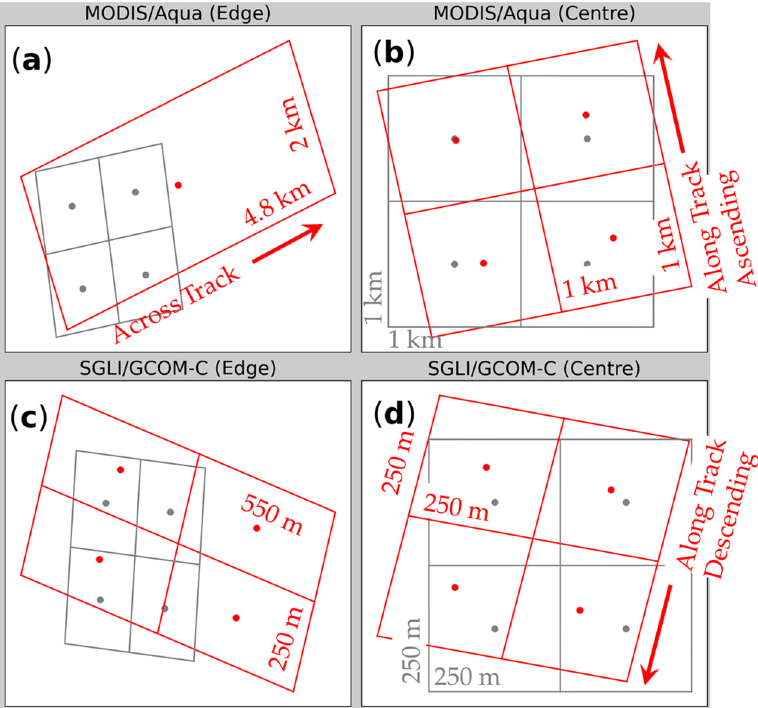
Figure A1. Illustrations of pixel resolution of swath (red) and of map-projected grid (gray) for MODIS/Aqua ( a , b ) and SGLI/GCOM-C ( c , d ). ( a , c ) Shows the pixel frame at the swath edge where the resolution degrades significantly. ( b , d ) Same as ( a , c ) but for the sub-satellite location with the resolution equal to the nominal value. The dots represent the pixel center for the swath (red) and map-projected (gray) grid. Note how far the pixels at the target grid projection are located from the swath center.